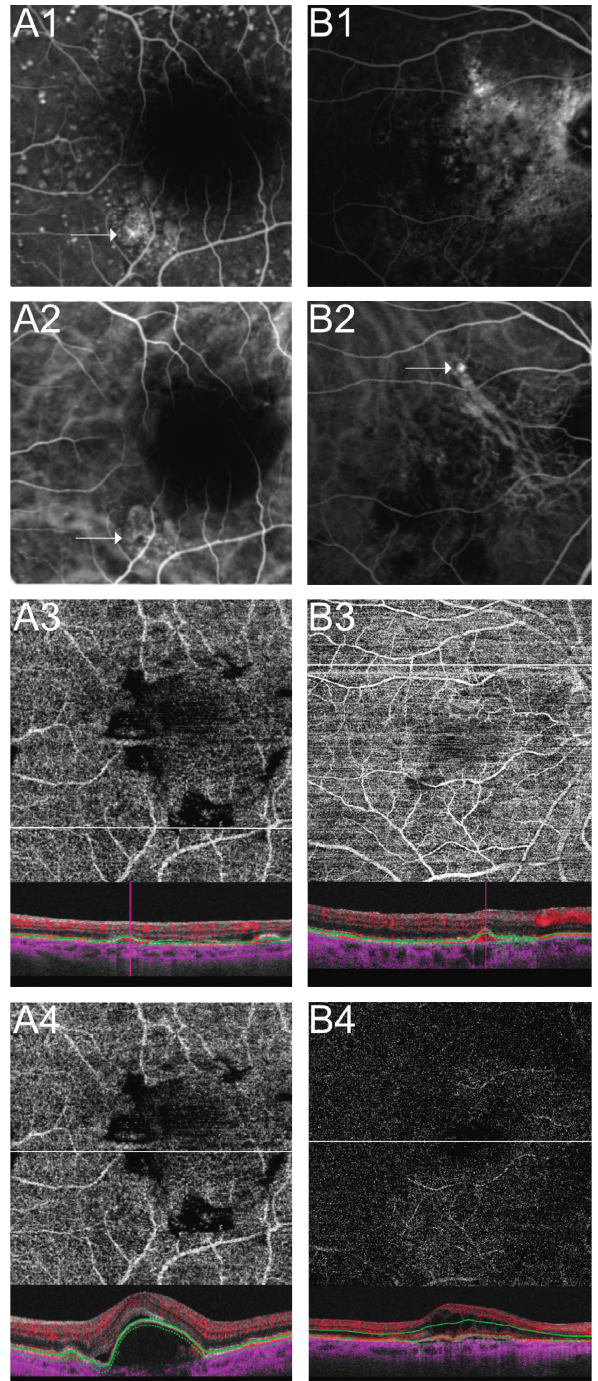
Figure 2: Detection of macular neovascularization (MNV) in age-related macular degeneration (AMD) by fluorescein angiography (FA), indocyanine green angiography (ICGA), and cross-sectional swept source-optical coherence tomography angiography (SS-OCTA). (A1) Early FA with drusen staining and a focal speckled hyperfluorescence (arrow) representing type 1 MNV in a left eye. (A2) Early ICGA with a circumscribed neovascular lesion (arrow) at the same location as shown in FA. (A3) Manual segmentation of a 4.5 × 4.5mm en-face OCTA CC slab without evidence of a MNV membrane below the retinal pigment epithelium (RPE) besides projection artifacts and signal loss but flow density in color coded cross-sectional SS-OCTA. (A4) Manual segmentation of a 4.5 × 4.5mm en-face OCTA CC slab across the fovea and cross-sectional SS-OCTA with no flow suspicious of a neovascularization in an otherwise dome-shaped pigment epithelium de- tachment. (B1) Ill-defined hyperfluorescence and drusen staining in early FA. (B2) ICGA revealed a hypercyanescent nodule consistent with a polypoidal lesion corresponding to (B3) cross-sectional flow density in SS-OCTA CC slab through the point of interest. (B4) 9 × 9 mm en- face OCTA OR slab at the fovea with hollow cystoid spaces besides projection artifacts but no evidence of